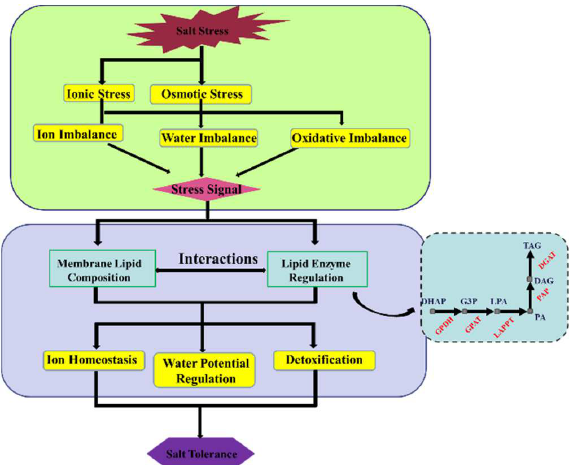
Figure 7. Salt stress mechanisms and membrane responsive regulations of membranes in plant cells.